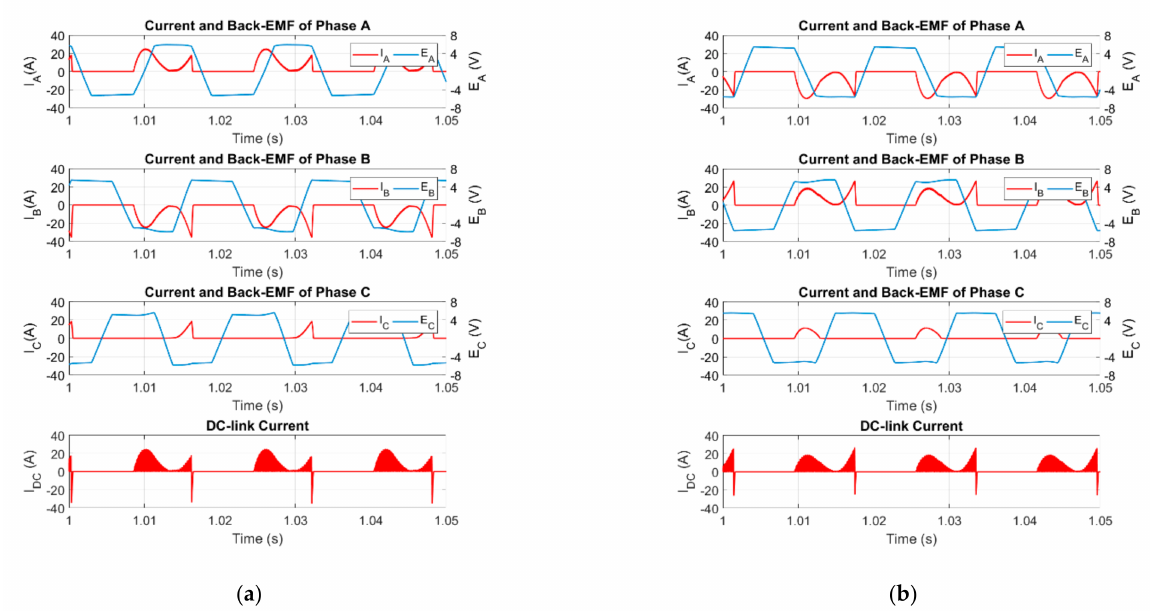
Figure 13. Phase currents and back-EMF voltages along with the DC-link current in case of 900 rpm and 10% of rated load under Hall-effect position sensors A and C double failure. ( a ) Defective sensors A and C at high state; ( b ) Defective sensors A and C at low state.